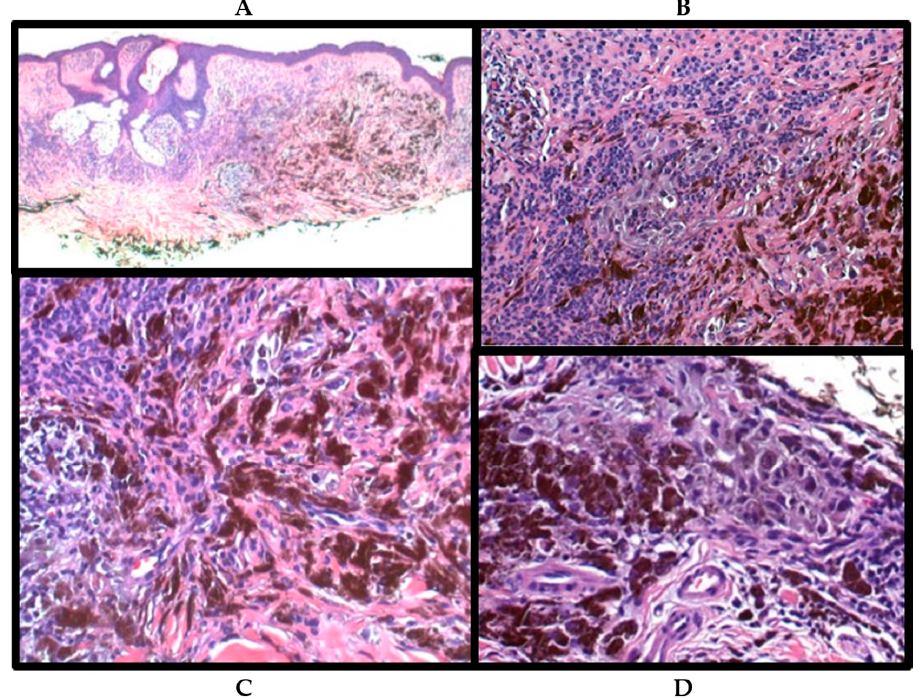
Figure 2. Shave biopsy of dermal melanocytic proliferation arising in the background of an intradermal melanocytic nevus ( A,B ). PEM arising in the intradermal nevus ( B – D ). The sections were stained with eosin and heamatoxylin (H&E). Brown color represent melanin pigment. Microscopic magnification for ( A ): ×4, for ( B ): ×10, for ( C , D ): ×20.